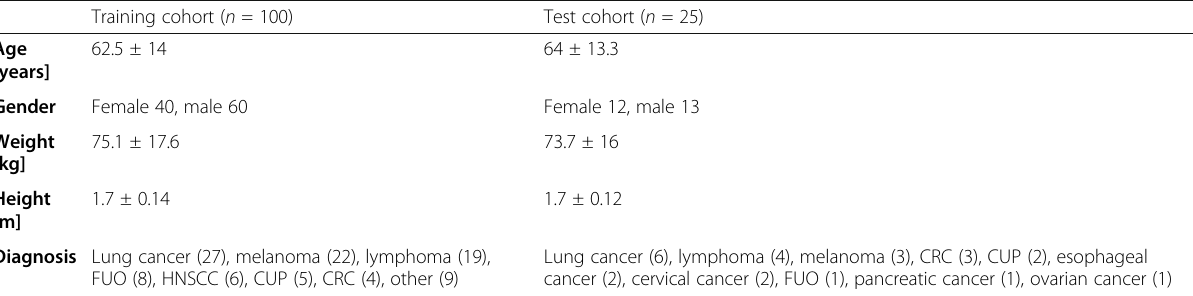
Table 1 Patient characteristics (FUO, fever of unknown origin; HNSCC, head and neck squamous cell cancer; CUP, cancer of unknown primary site; CRC, colorectal cancer)